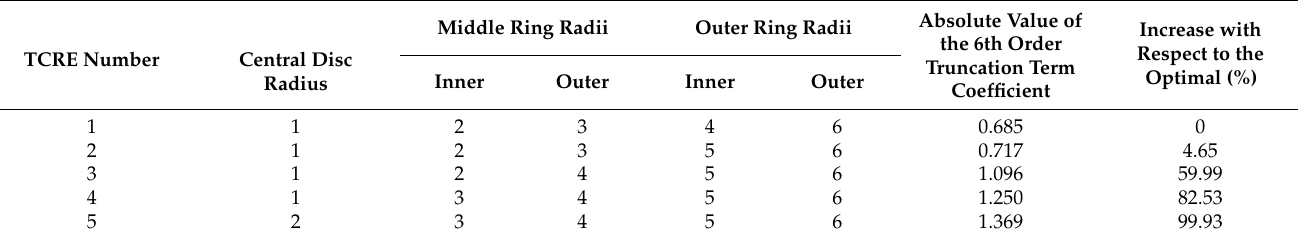
TCRE Number Central Disc